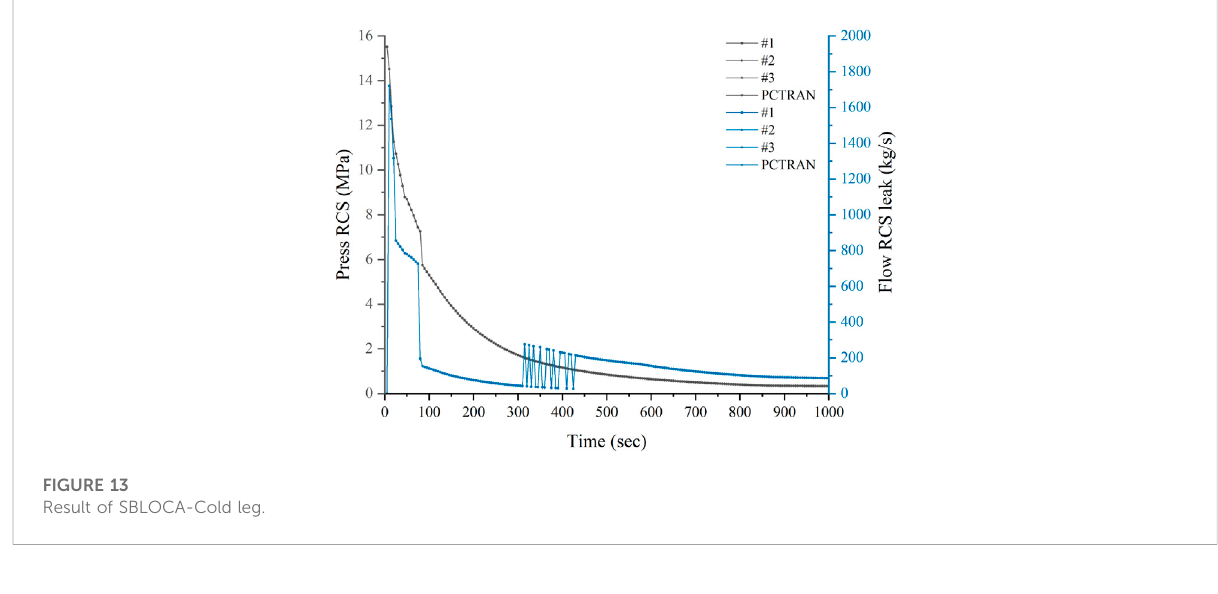
FIGURE 13 Result of SBLOCA-Cold leg.